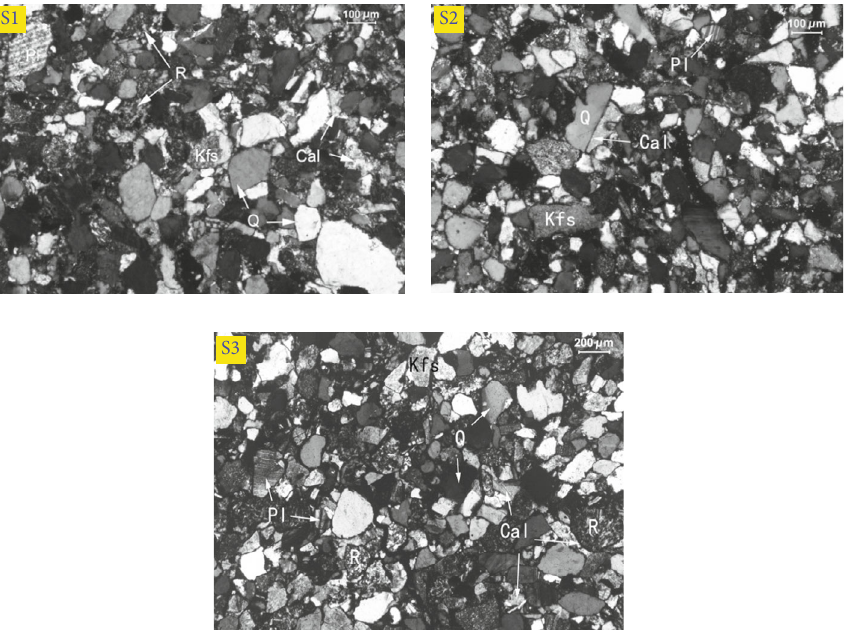
Figure 1: Optical microscope images of the three tested sandstones. Table 1: Mineral constituents of the three